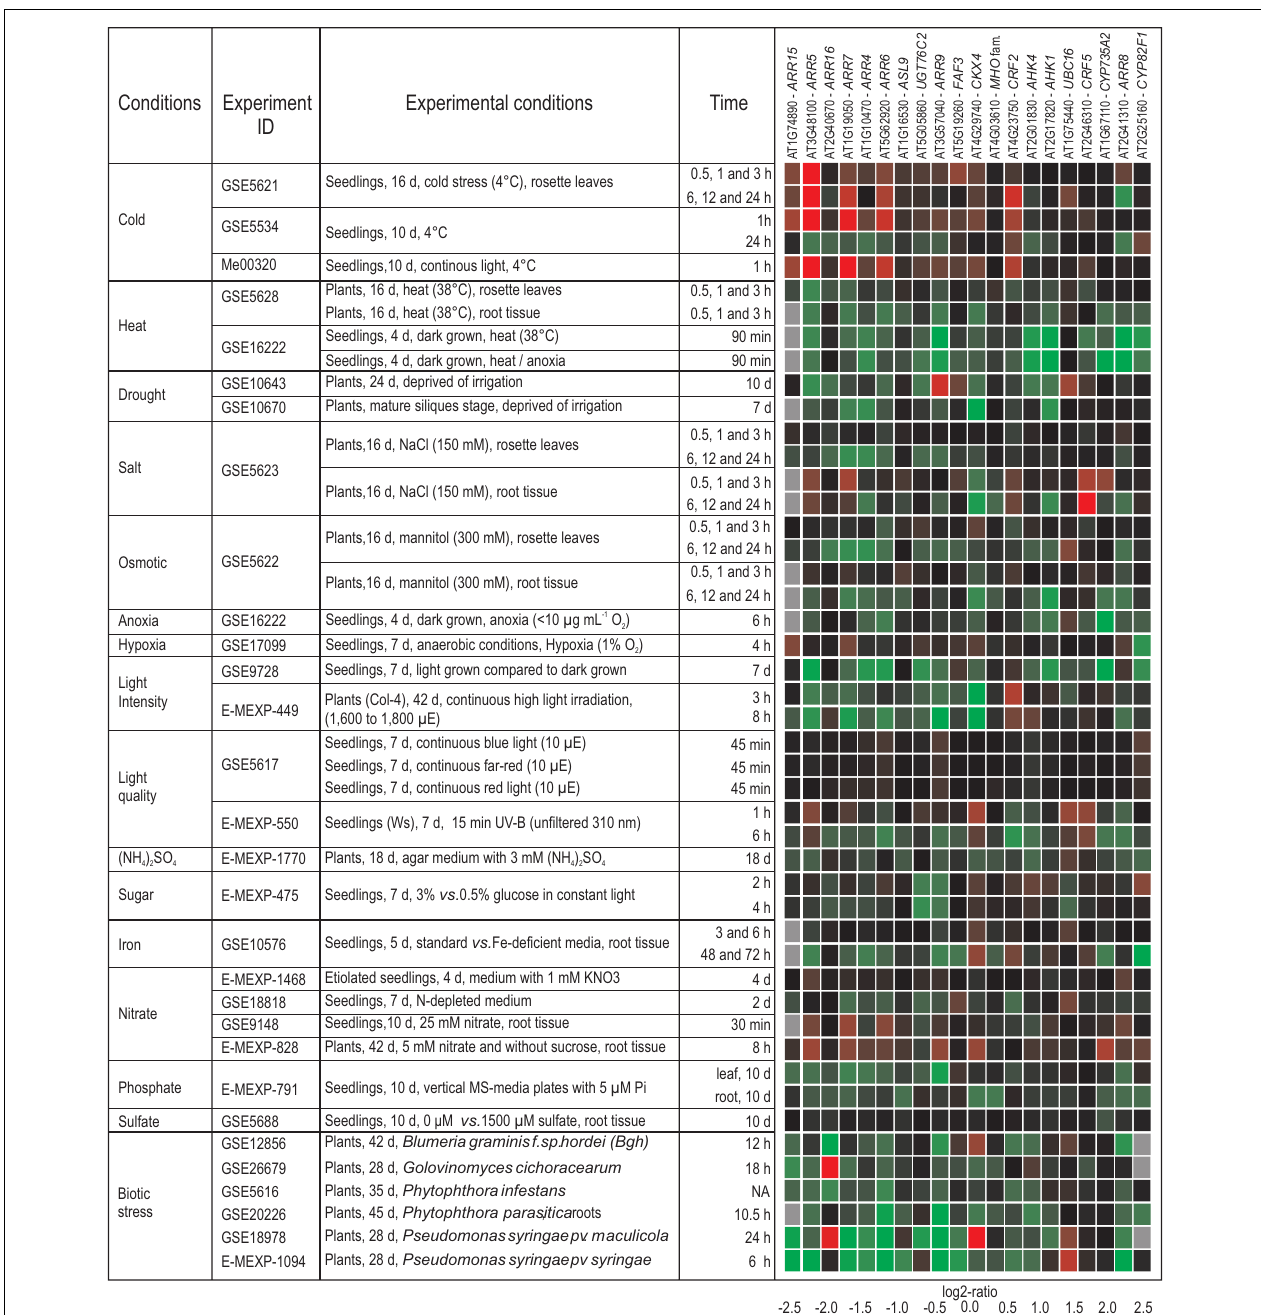
time points were preferred.The gene expression responses are calculated as log 2 -ratios between the signal intensities from different stress or nutritional treatments compared to control or mock-treated samples.The resulting heatmap is color coded as indicated, and thus reflects the up- (red color) or downregulation (green color) of genes. A gray color indicates that gene expression was not detectable in both treatment and control conditions.The individual experiments are available from various repositories, such as gene expression omnibus (GEO; Edgar et al., 2002), ArrayExpress (Rocca-Serra et al., 2003), andTAIR (Swarbreck et al., 2008), and can be retrieved by using their unique ID. Abbreviations used in the figure: d, days; vs., versus;Ws, Wassileskija; Col-4, Columbia-4; NA, not